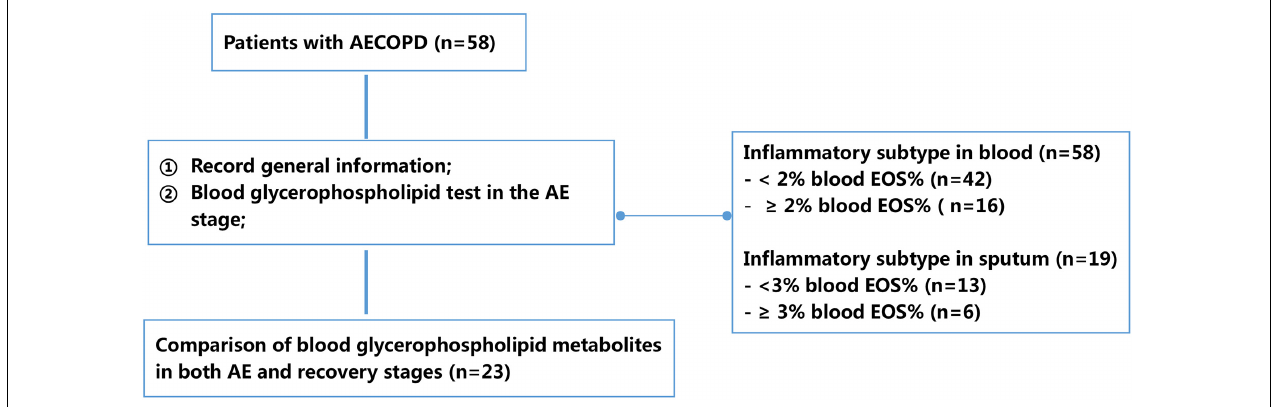
FIGURE 1 | Flowchart of study design. AECOPD, acute exacerbation of chronic obstructive pulmonary disease; EOS, eosinophil percentage.